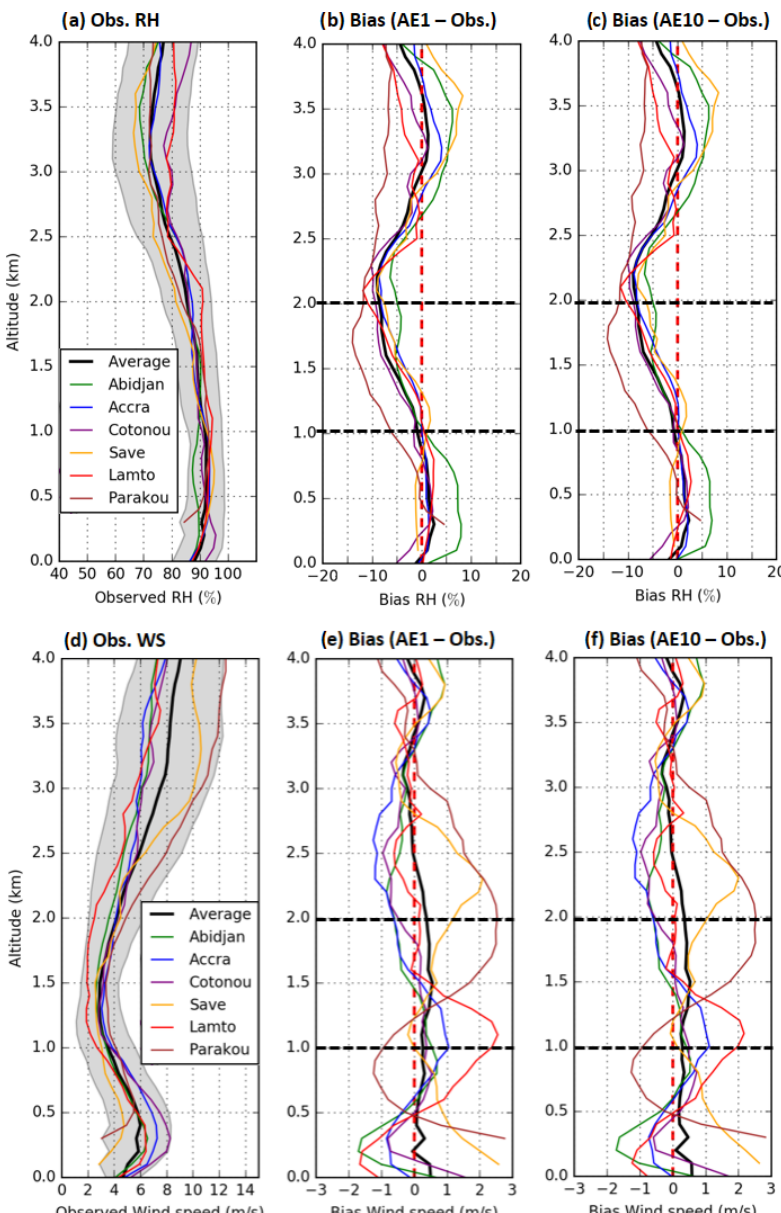
Figure 3. Observed mean vertical profiles of wind speed (in ms − 1 ), and relative humidity (RH in %) averaged for all profiles over the period 1–7 July 2016 at Abidjan (green line) and Lamto (red line) in Ivory Coast, Accra in Ghana (blue line), Cotonou (purple line), Savè (orange line) and Parakou (brown line) in Benin. The mean and standard deviation at the six locations are represented by the black line and the gray shading (a, d) . WRF-derived variables are interpolated to the radiosonde positions and (b, c; e, f) vertical biases (mod-obs) are presented at each location (colored line) and for the average of the six locations (black line) for the experiments AE1 and